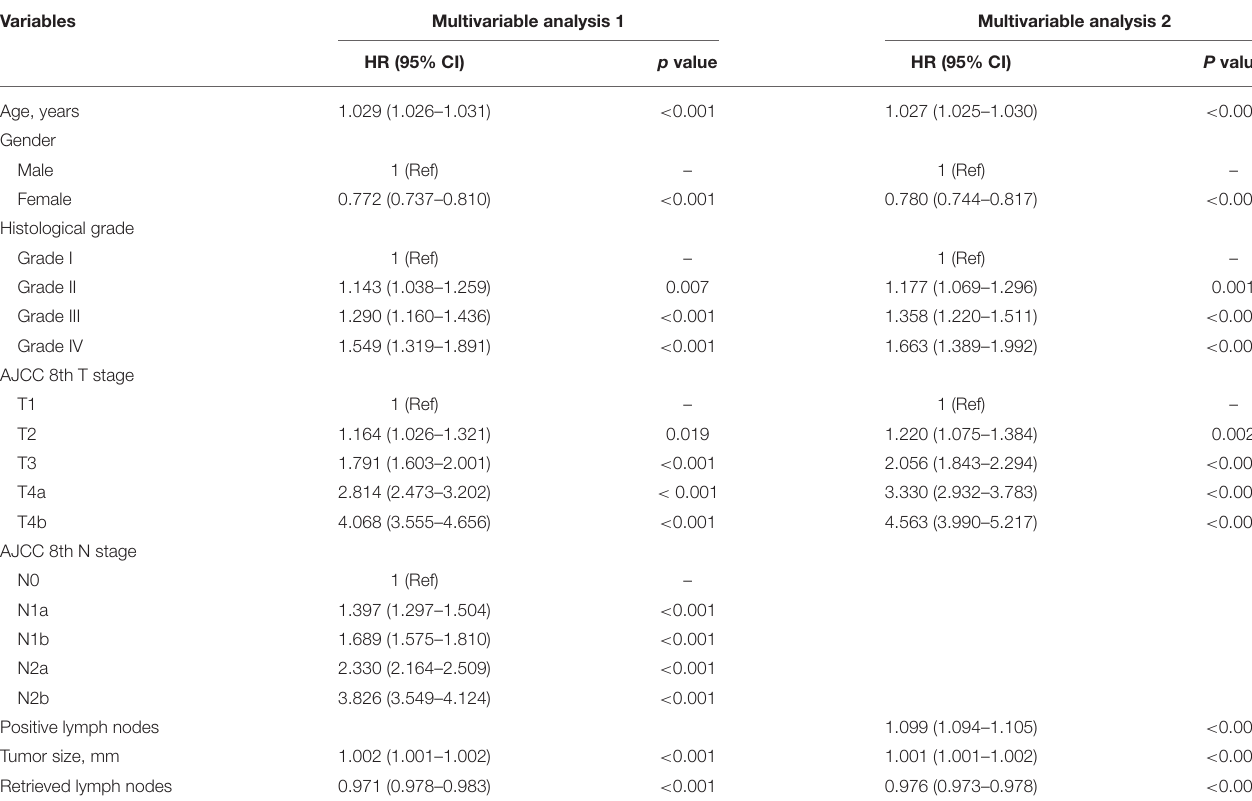
TABLE 3 | Multivariable analyses of the training cohort.